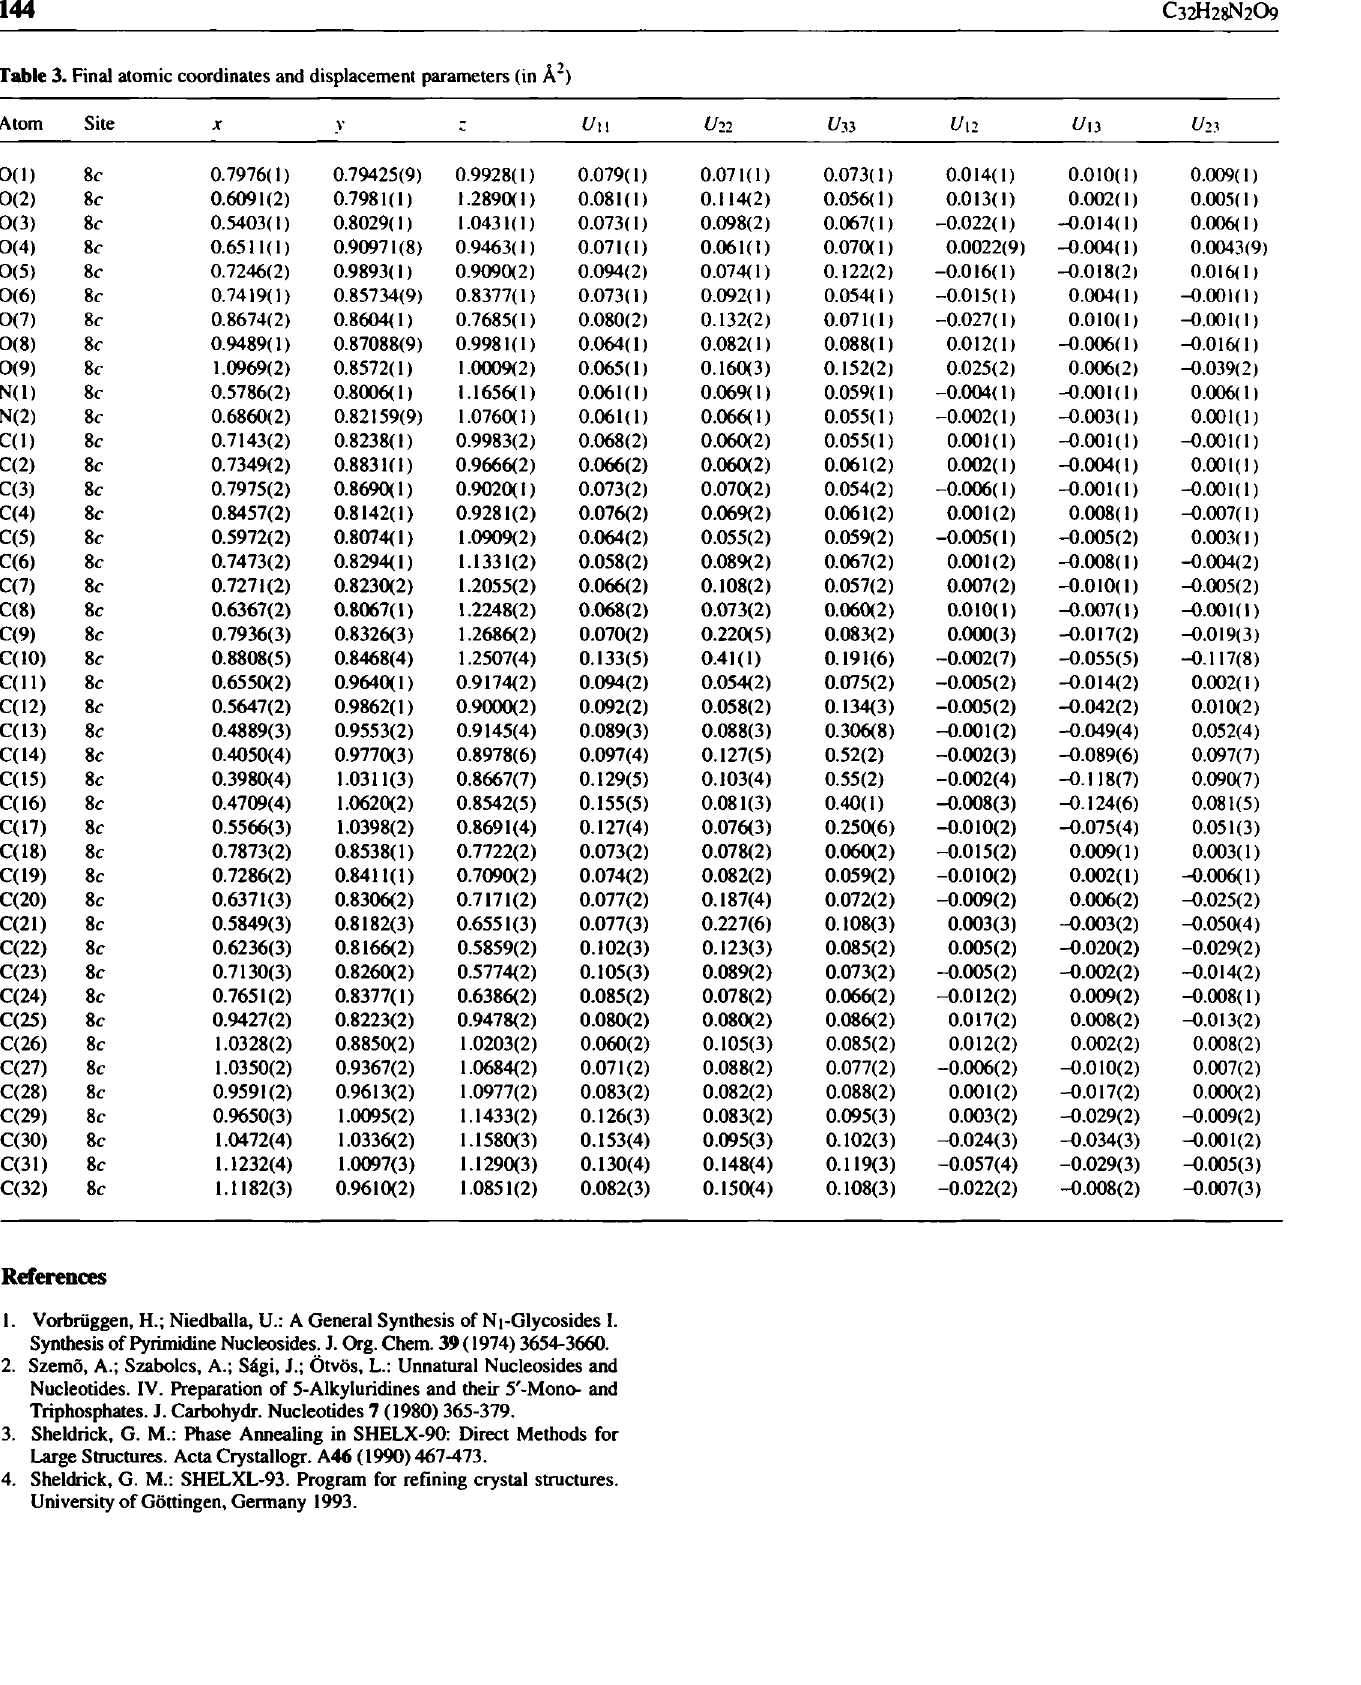
Table 3. Final atomic coordinates and displacement parameters (in